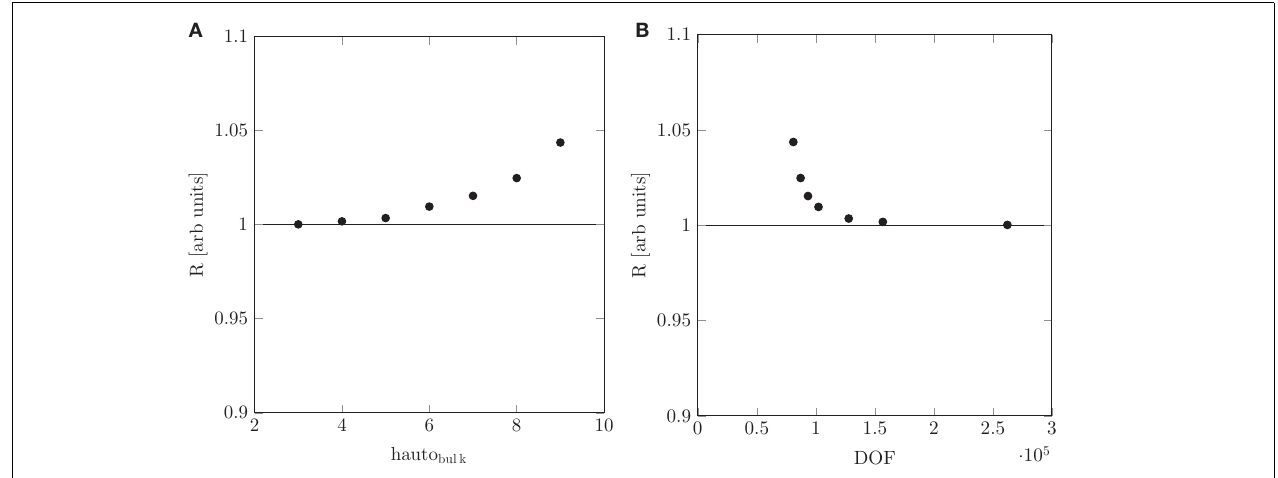
FIGUREA1 | Mesh convergence plots. Hydraulic resistance R plotted as a function of (A) hauto bulk and (B) the number of degrees of freedom DOF with hauto pore = 4 and N sweep =